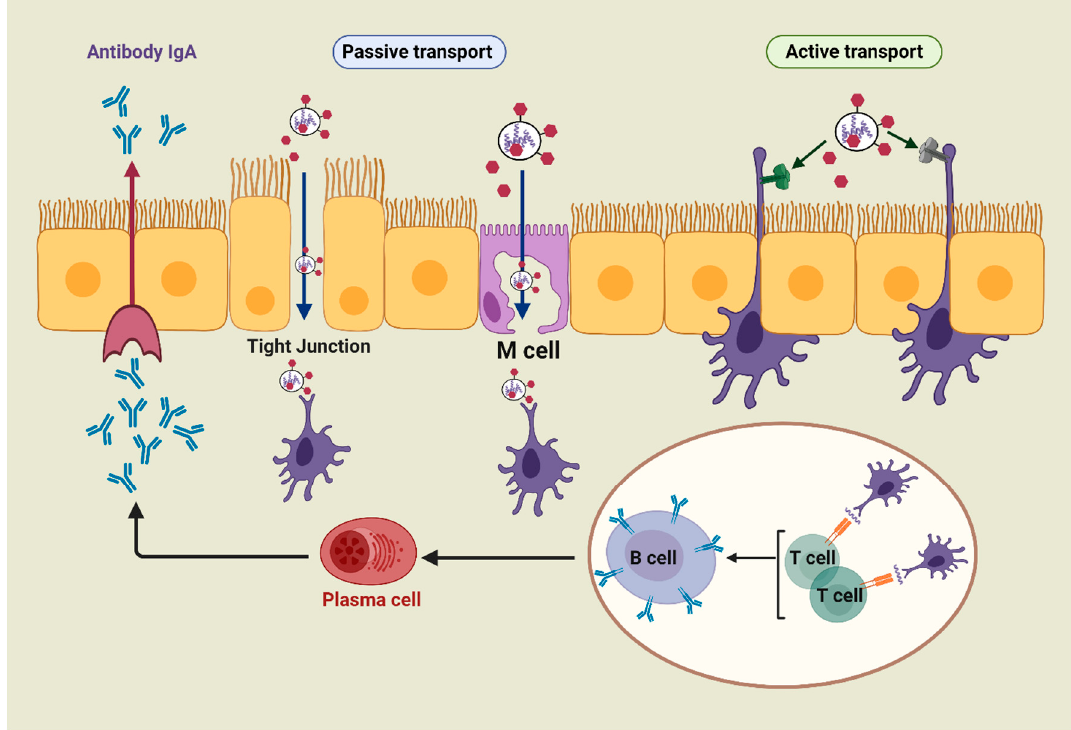
Figure 2. The simplified pathway of mucosal immunity.